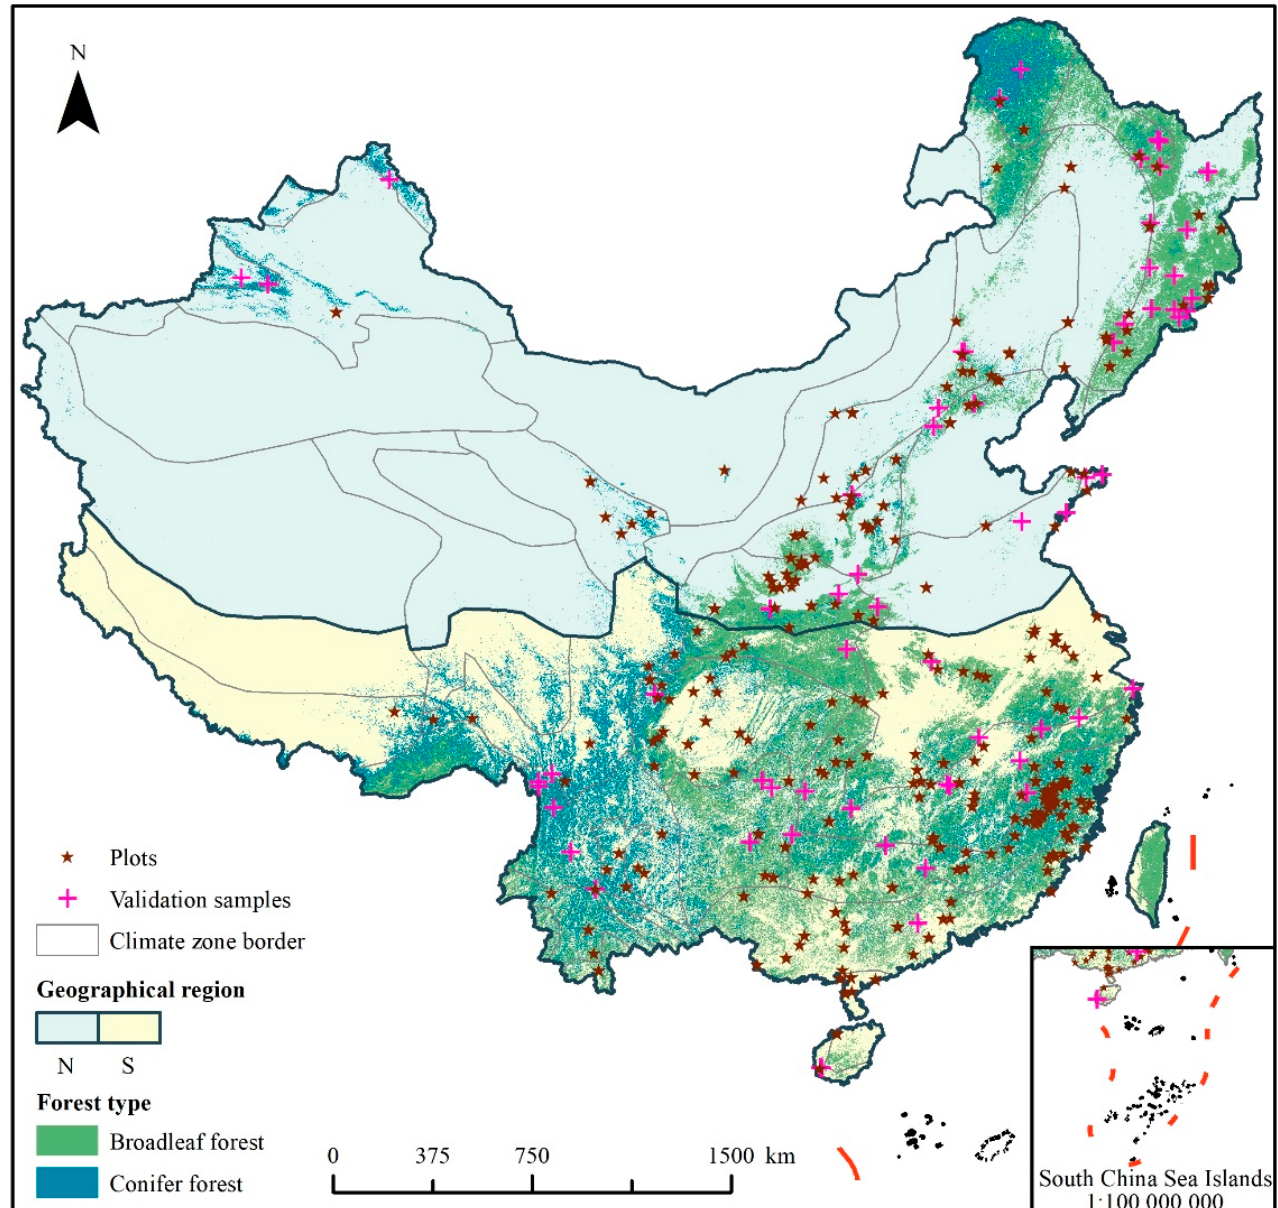
Figure 1. Spatial distribution of the forest plots in different geographical regions. N denotes north China; S denotes south China. Validation samples are used for validation at the pixel level described in Section 2.4. The land cover product provides three main forest types including broadleaf, conifer, and mixed forest. There are four subtypes in broadleaf, four subtypes in conifer, and two subtypes in mixed forest. Take broadleaf as an example, there are open evergreen broadleaf, closed evergreen broadleaf, open deciduous broadleaf, and closed deciduous broadleaf. The four subtypes were merged to establish allometric relationships for broadleaf in order to have sufficient samples to maintain statistical significance of the results due to the limited number of forest plots, and conifer was treated in the same way. In addition, there were almost no mixed forest samples due to too few pixels of mixed forest, thus we merged the mixed forest pixel to the nearest pixel of other forest